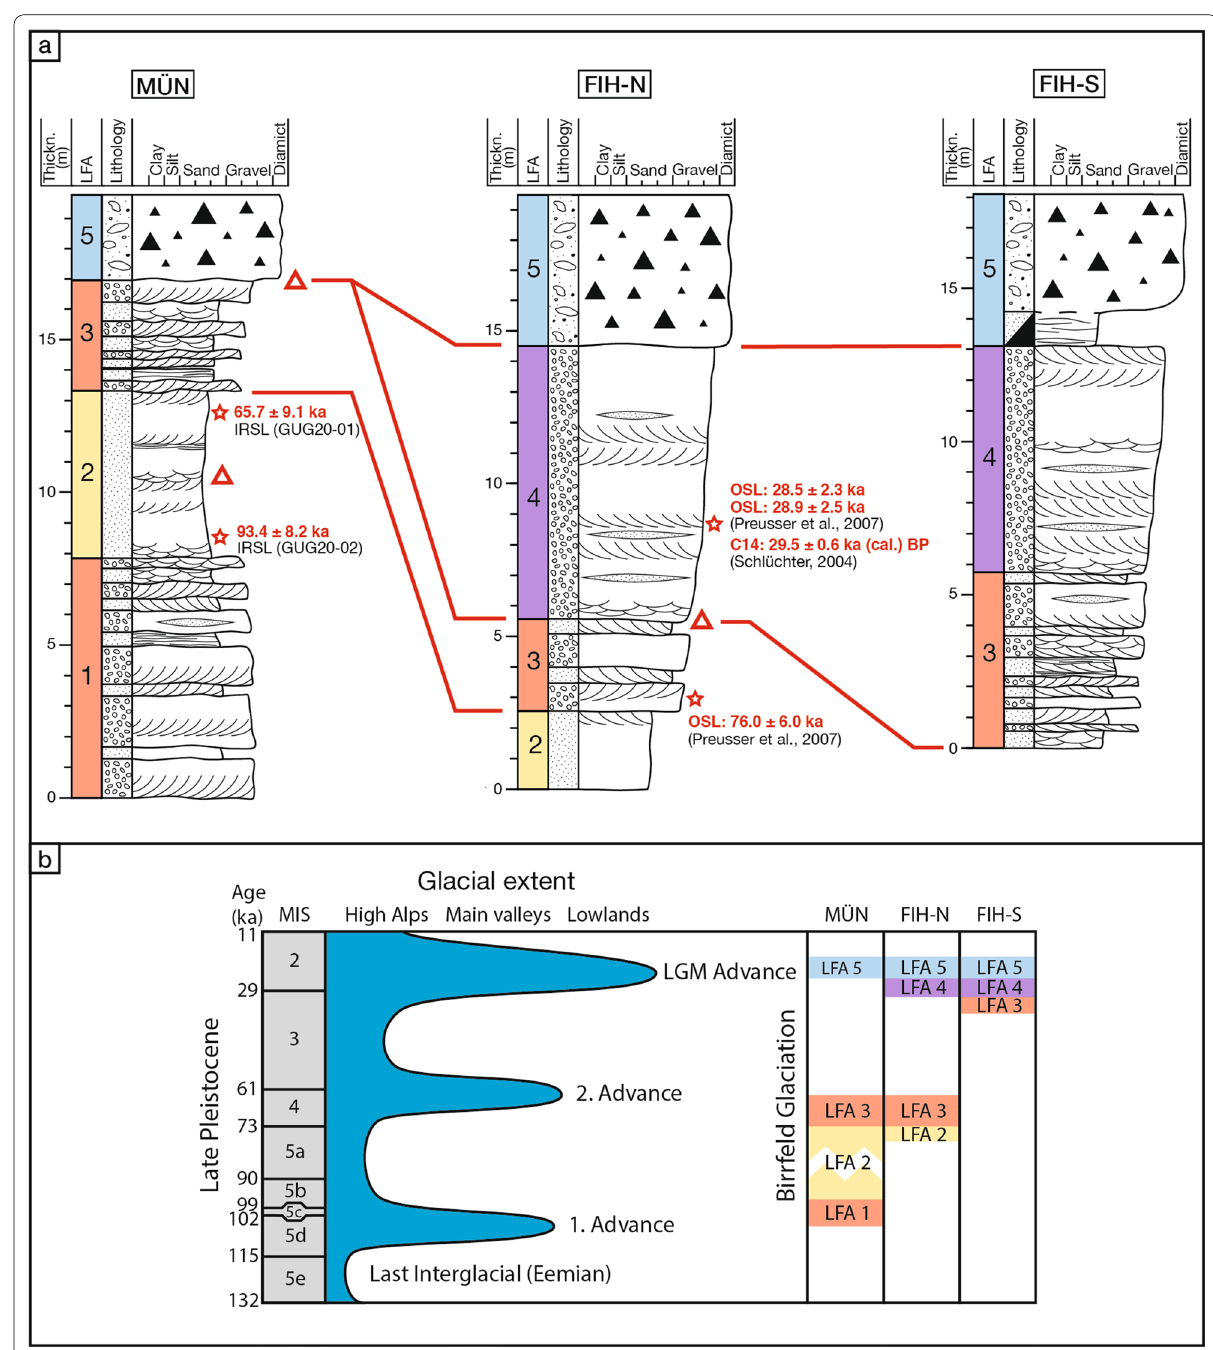
Fig. 10 a Correlation of the sedimentological logs at Müntschemier (MÜN; Fig. 5), the northern part of Finsterhennen (FIH-N; Fig. 6), and the southern part of Finsterhennen (FIH-S; Fig. 7). Ages are projected and indicated as red stars and possible hiatus as red triangle. See Fig. 2 for location of logs, and Fig. 5 for legend. b Possible timing and ice extents of three glacial advances during the last glacial cycle (Birrfeld Glaciation, modified from Ivy-Ochs et al. (2008)) and correlated with the lithofacies associations (LFA) recorded at Müntschemier and Finsterhennen. The first and second advance possibly reached the study area. The LGM advance was more extensive and covered this area with several hundred metres of ice (Bini et al., 2009). The Marine Isotope Stage boundaries are taken from Martinson et al. (1987) and Shackleton et al.